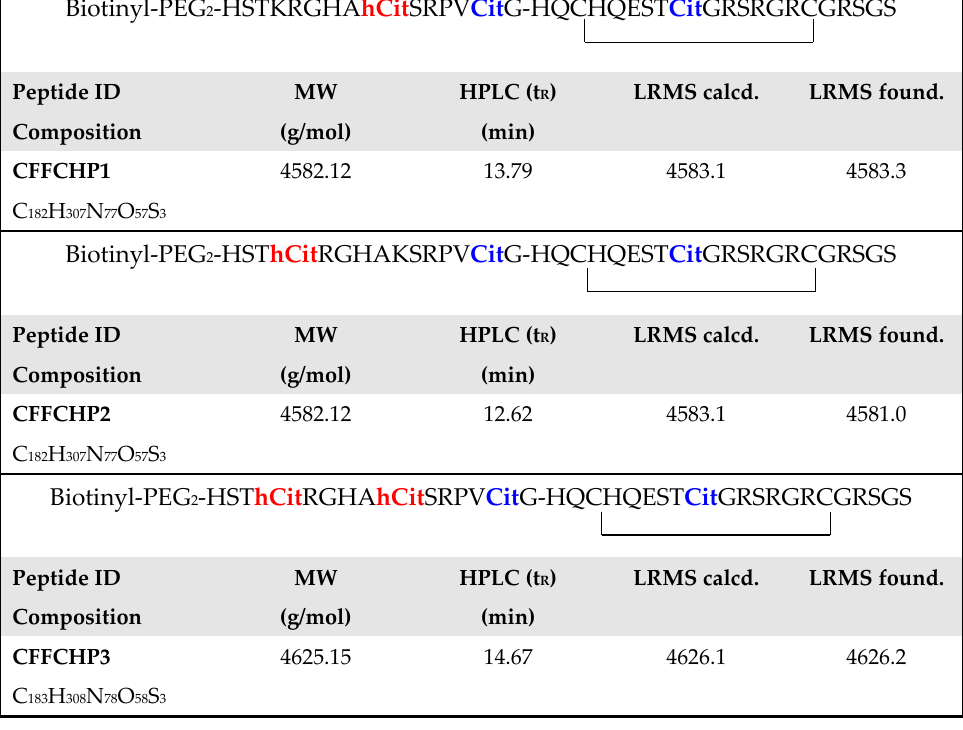
Figure 2. Primary sequences of citrullinated/homocitrullinated chimeric peptides. Peptide identifi- cation (ID), elemental composition, molecular weight (MW), chromatographic retention time (t R ) by HPLC and mass calculated and found by low-resolution mass spectrometry (LRMS) were obtained by ESI-MS.